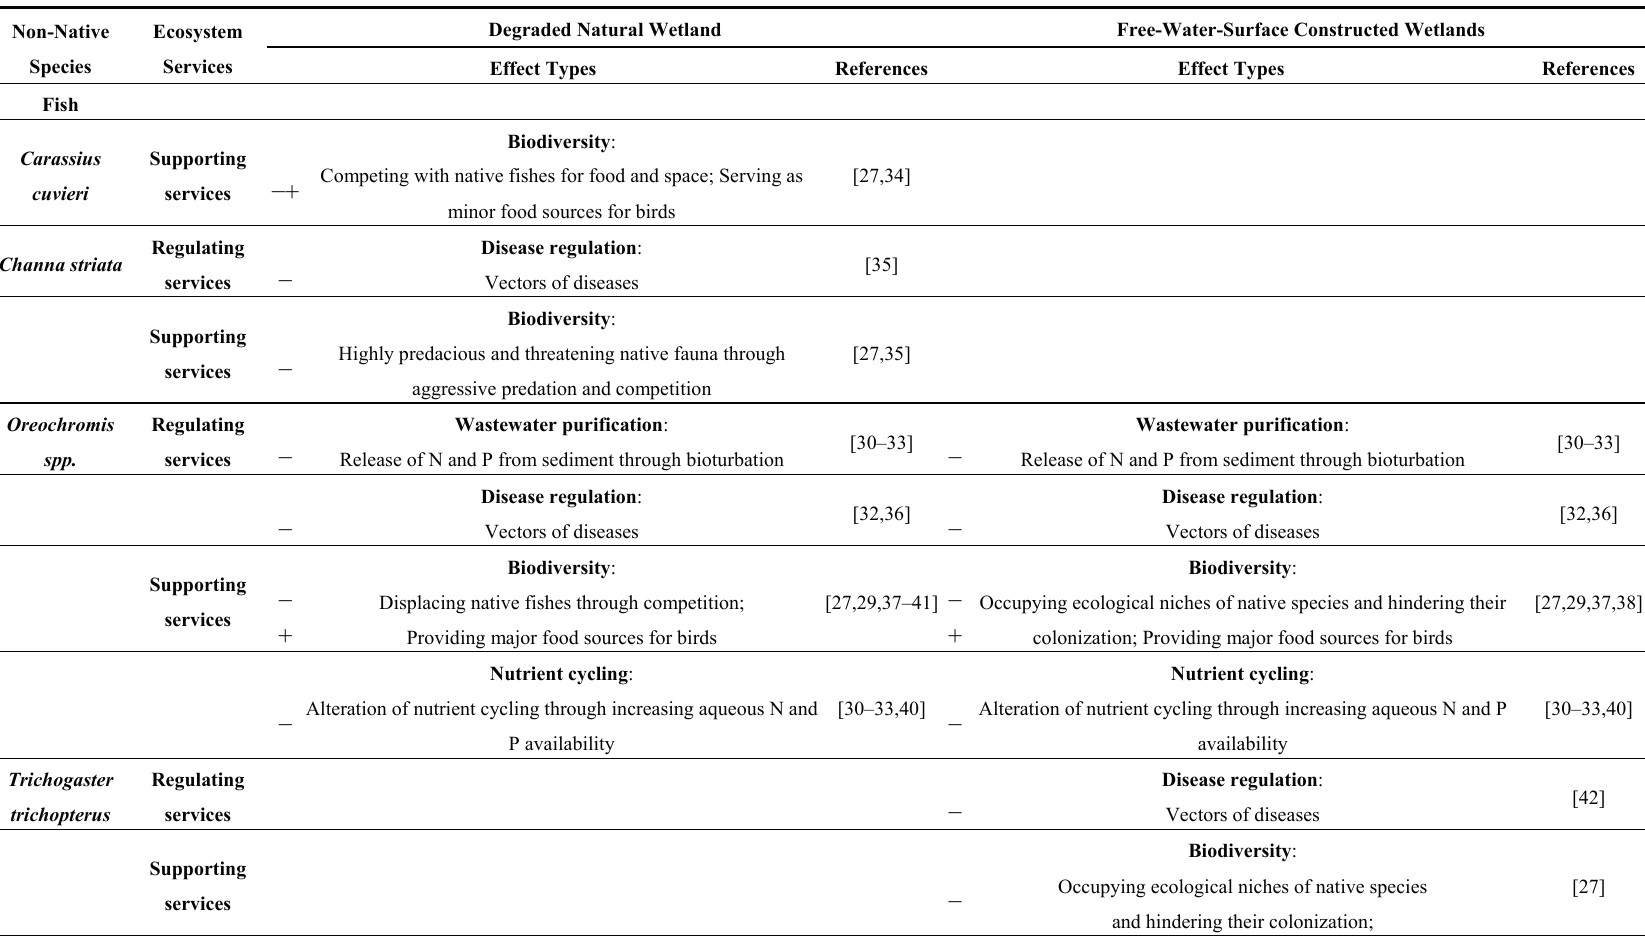
Table 4. Effect types (damage = “ − ”; benefit = “+”) of non-native fish and bird species on the ecosystem services of our study urbanized wetlands. Effect types were classified into three categories including supporting, regulating and cultural